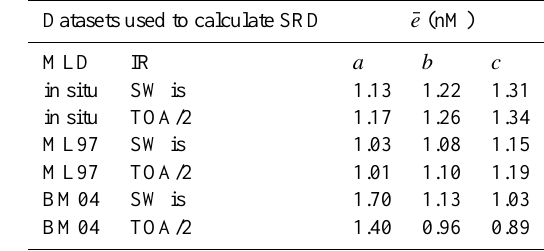
Table 3. Mean residuals ( ¯ e ,nM) between measured DMS concen- trations and those predicted by VS07, using all mixed layer depth (MLD) and irradiance (IR) data combinations and the three linear relationships reported in Vallina and Sim´o (2007). The first column indicates which of the three mixed layer depth (MLD) datasets was used, determined in situ or from the ML97 or BE04 climatologies. The second column contains the incoming radiation (IR) dataset used, either shortwave radiation measured in situ (SW is) or the estimated surface shortwave radiation (TOA/2). Further details of these data are given in the methods section. The relationships were determined for: a =Blanes Bay, DMS=0.138 + 0.028.SRD; b =the global ocean, DMS=0.492 + 0.019.SRD and c =the Sargasso Sea, DMS=0.51 +